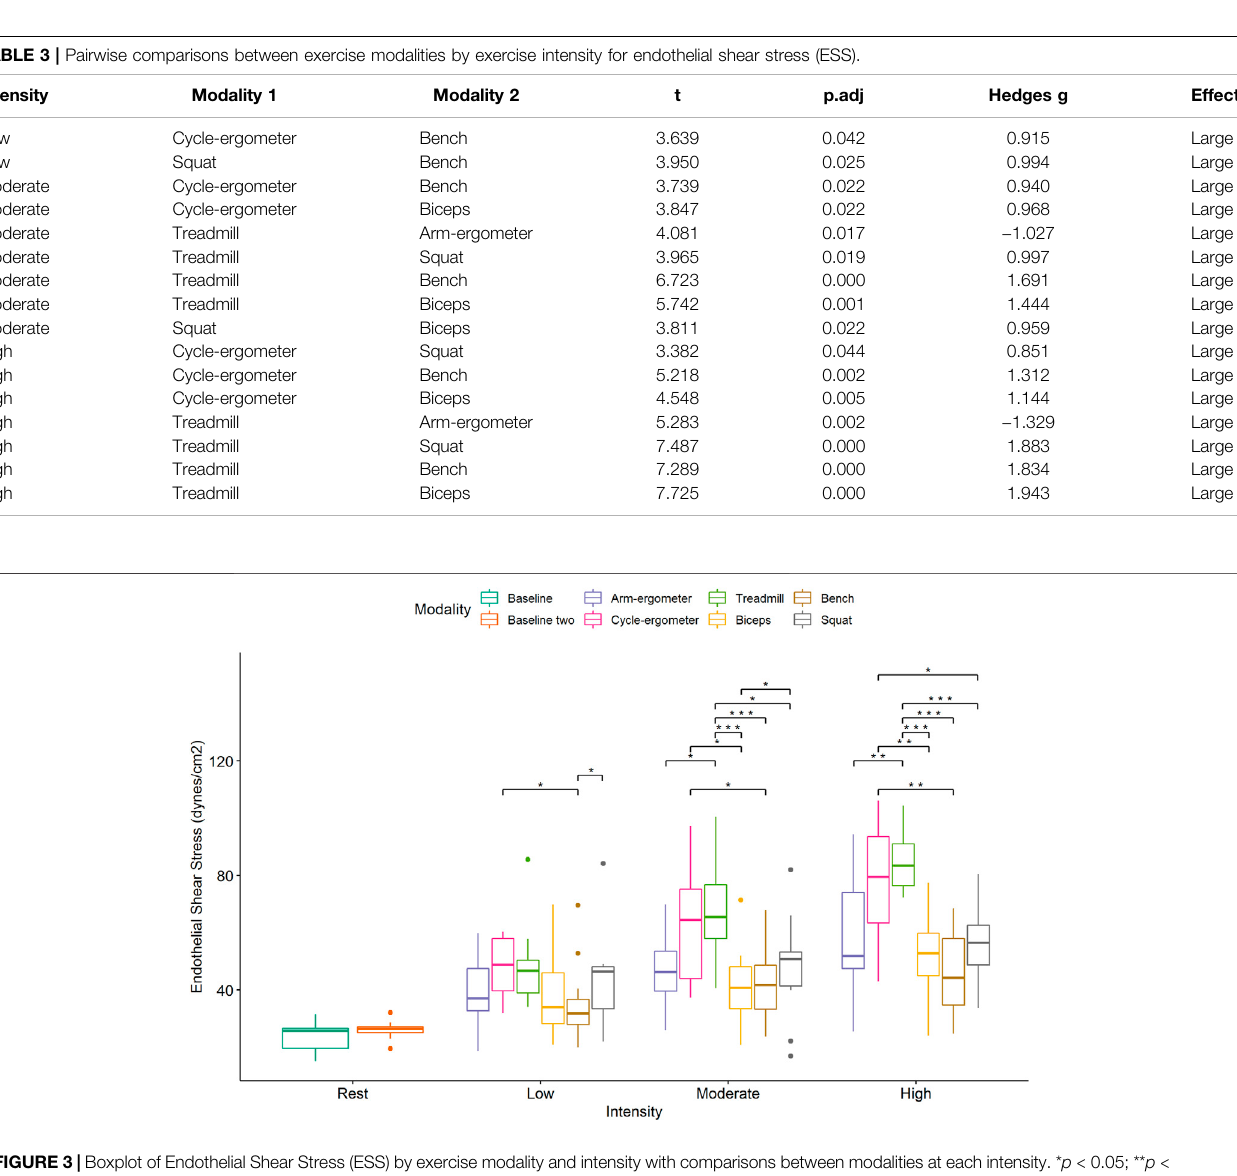
Frontiers in Physiology |